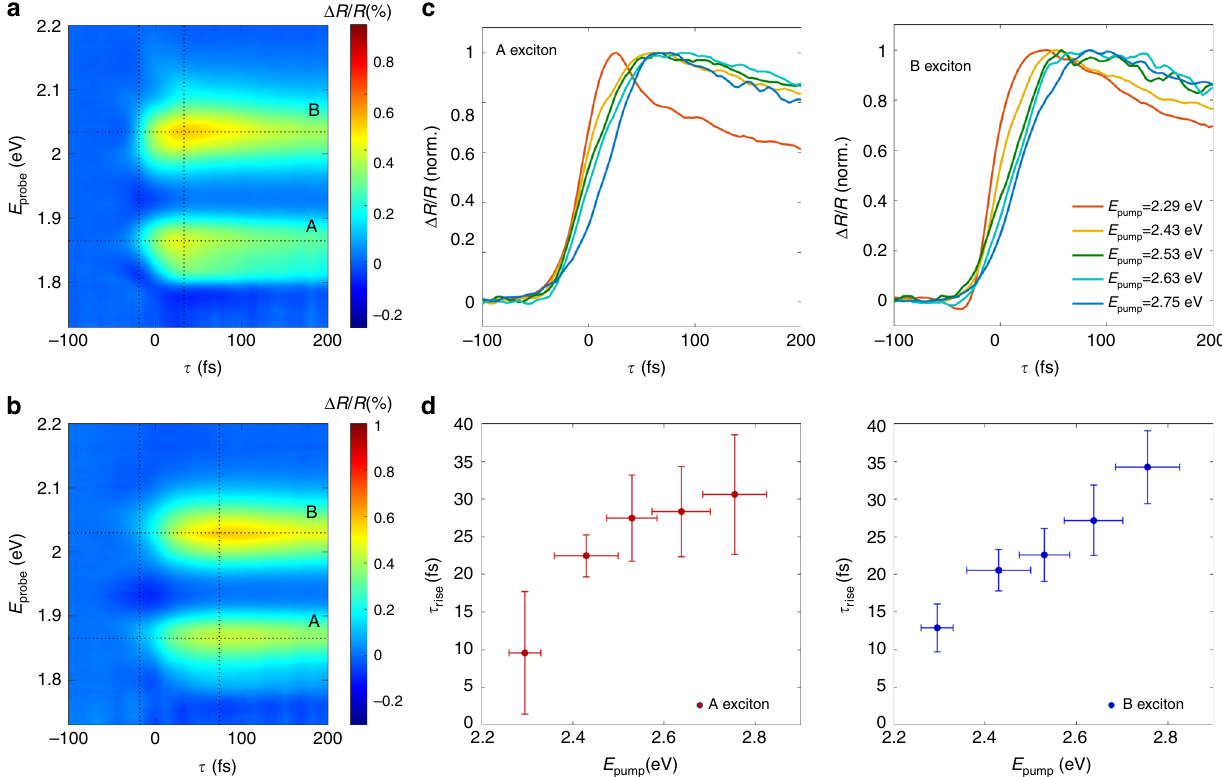
Fig. 2 Energy-dependent exciton formation process. Δ R/R maps measured on 1L-MoS 2 photoexcited a at 2.29 eV and b at 2.75 eV. The measurements are performed at room temperature. The horizontal dashed lines pass through the maximum of the Δ R/R spectrum at the energies of the A 1 s /B 1 s exciton transitions, while the vertical lines mark the temporal range from 10 to 90% of the build-up signal. The excitation fl uence is 5 μ Jcm − 2 . Pump and probe beams have parallel and linear polarizations. The time zero is de fi ned, for each measurement, as the maximum of the cross-correlation signal between the pump and the probe pulses as explained in the Methods. c Temporal cuts of the Δ R/R maps measured across the A 1 s and B 1 s excitonic resonances for increasing pump photon energy. d Pump photon energy dependence of τ rise . Horizontal error bars are determined by the bandwidth of the pump pulses; vertical error bars are obtained from the fi ts of the time